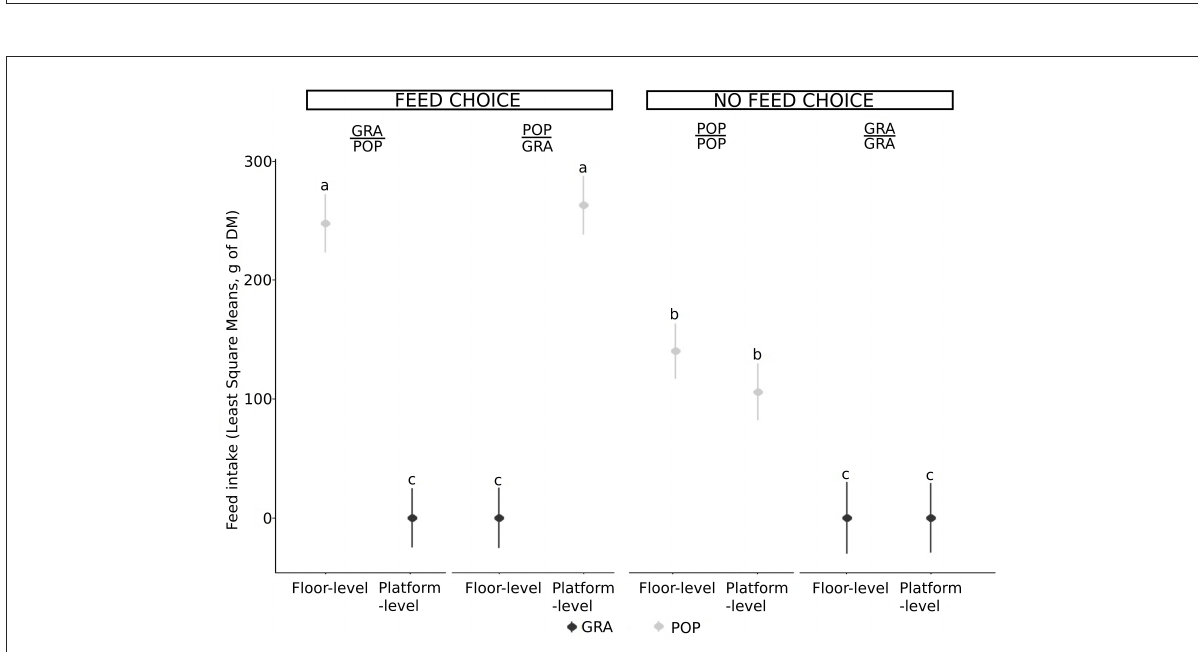
FIGURE4 Least Square means ( ± SE) of the quantity of each feed type (GRA: cut grass and POP: poplar leaves) eaten from each feeder (platform-level feeder and floor-level feeder) per goat ( n = 16, with two repetitions per individual) for Exp2, depending on the combination of feed type and feeding height (Platform/Floor: POP/POP, GRA/GRA, POP/GRA and GRA/POP), grouped according to the possibility of choosing a feed item or not. Tests where no feed was eaten have been excluded ( n = 4 GRA/GRA). The dot and bars represent the LSmean and standard error of each combination. Significant differences indicated by the model ( P < 0.05) are represented by different letters. The interaction between the feed type and the possibility to choose between feed or not was